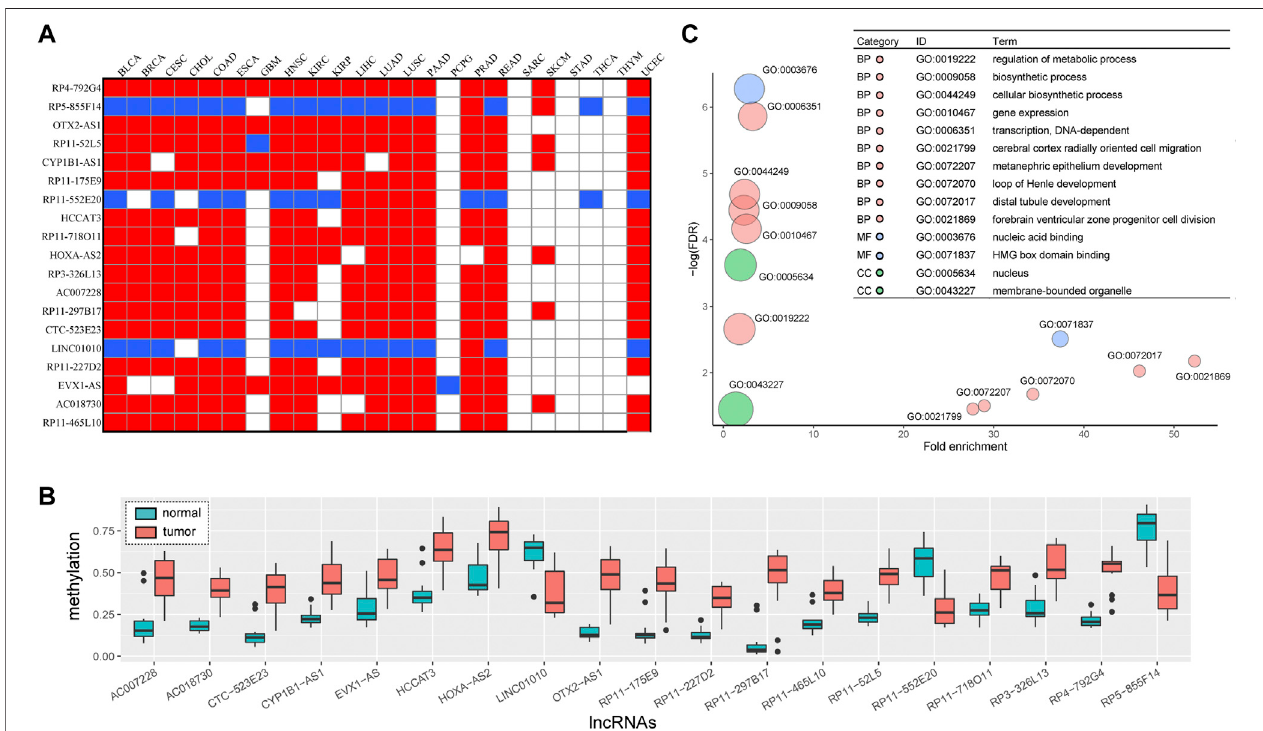
FIGURE8| CommonDMlncsofcancers (A) MethylationchangesofcommonDMlncsincancers.Redindicatesup-methylationofthelncRNA,whileblueindicates down-methylation in corresponding cancer (B) The functions of common DMlncs in cancer. Red represents a biological process (BP), blue represents a molecular function(MF),greenrepresentscellcomponent(CC),andthesizeofthebubblerepresentstheamountoflncRNAenriched (C) Acomparisonofthemethylationstatesof common DMlncs. Red represents tumor samples, while blue represents normal samples.